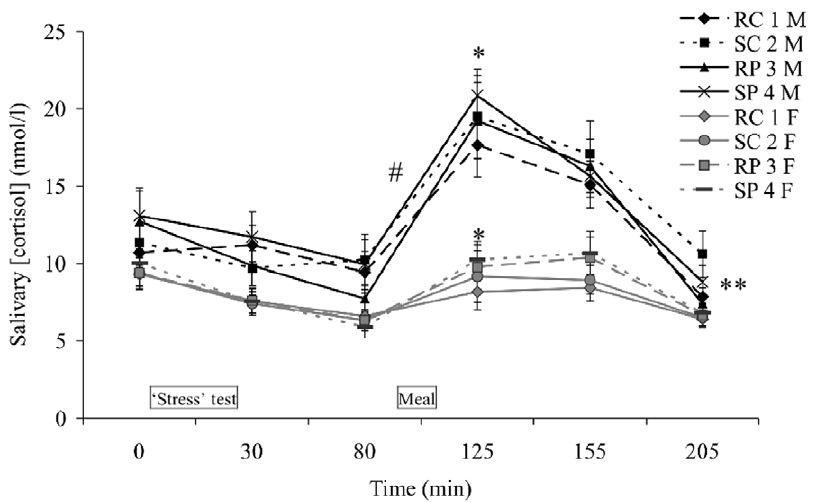
Figure 2. Salivary cortisol concentrations (mean ± SEM) at six time points (0, 30, 80, 125, 155, and 205 min) throughout the four test sessions: rest-carbohydrate (RC), stress-carbohydrate (SC), rest-protein (RP), stress-protein (SP); for men (n=19, M) and women (n=19, F). **p , 0.0001 for overall (AUC) higher cortisol levels in men vs. women; # p , 0.05 for higher meal-induced increase in cortisol levels in men vs. women (time point 80–125 min); *p , 0.03 for increased cortisol levels in men in all conditions, in women in RP and SP (time point 80 vs. 125 min).